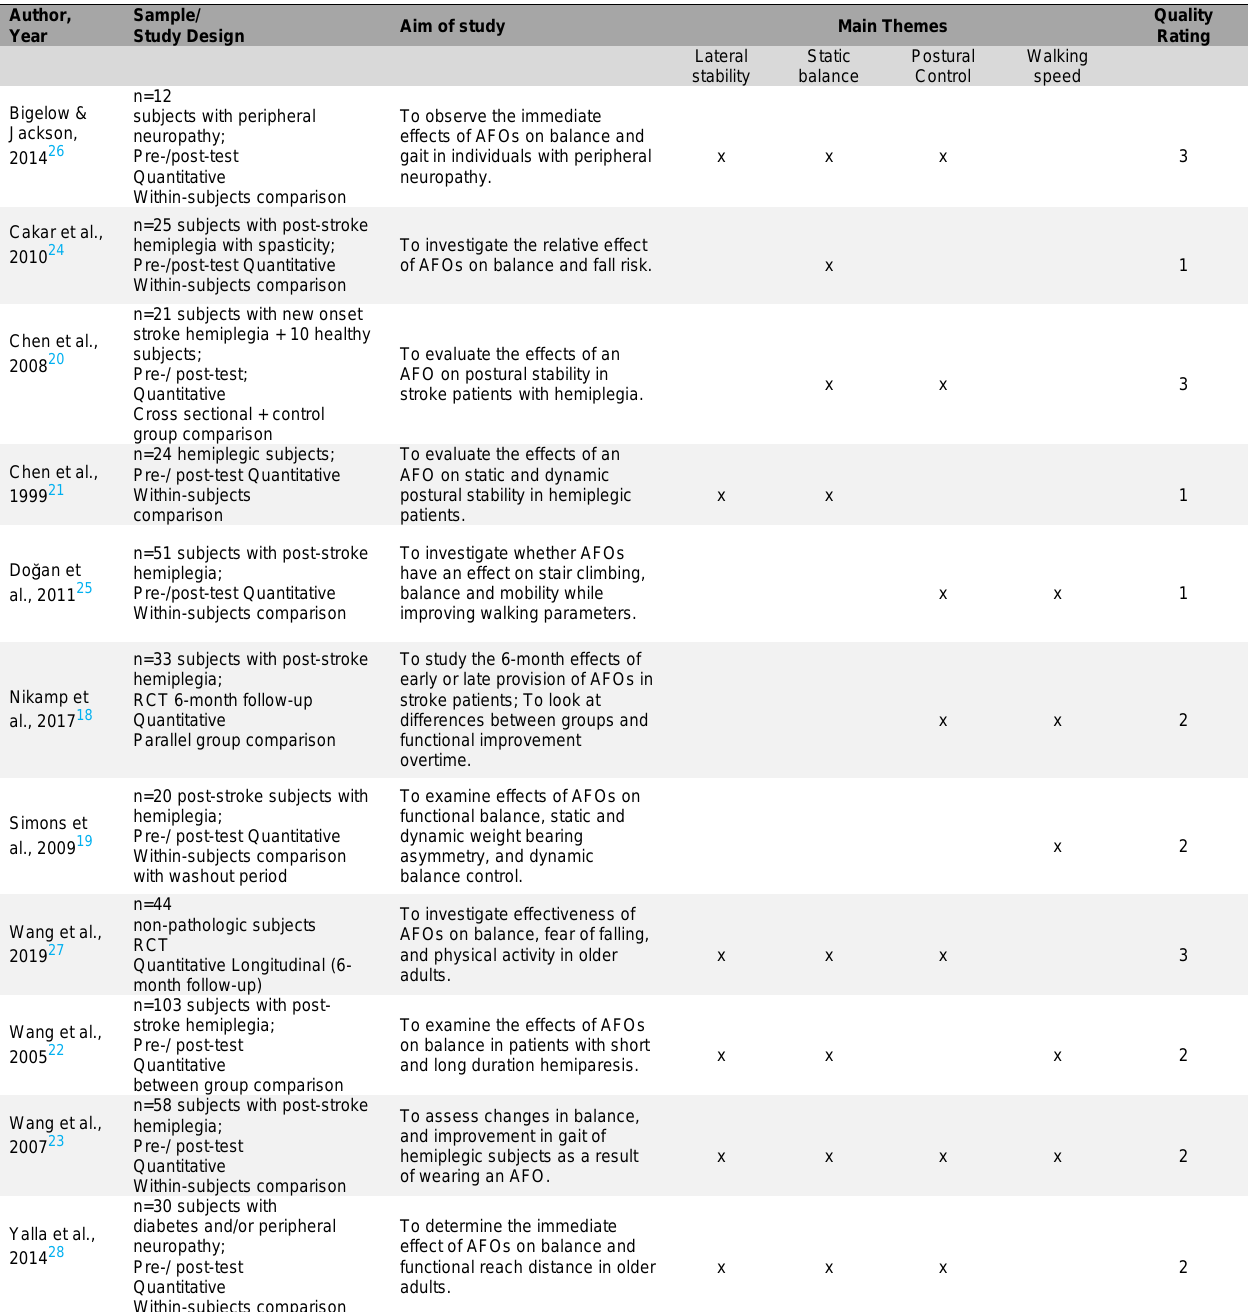
Table 1: Summary of the main ideas about the affect ankle-foot orthoses have on balance in older adults. Author,